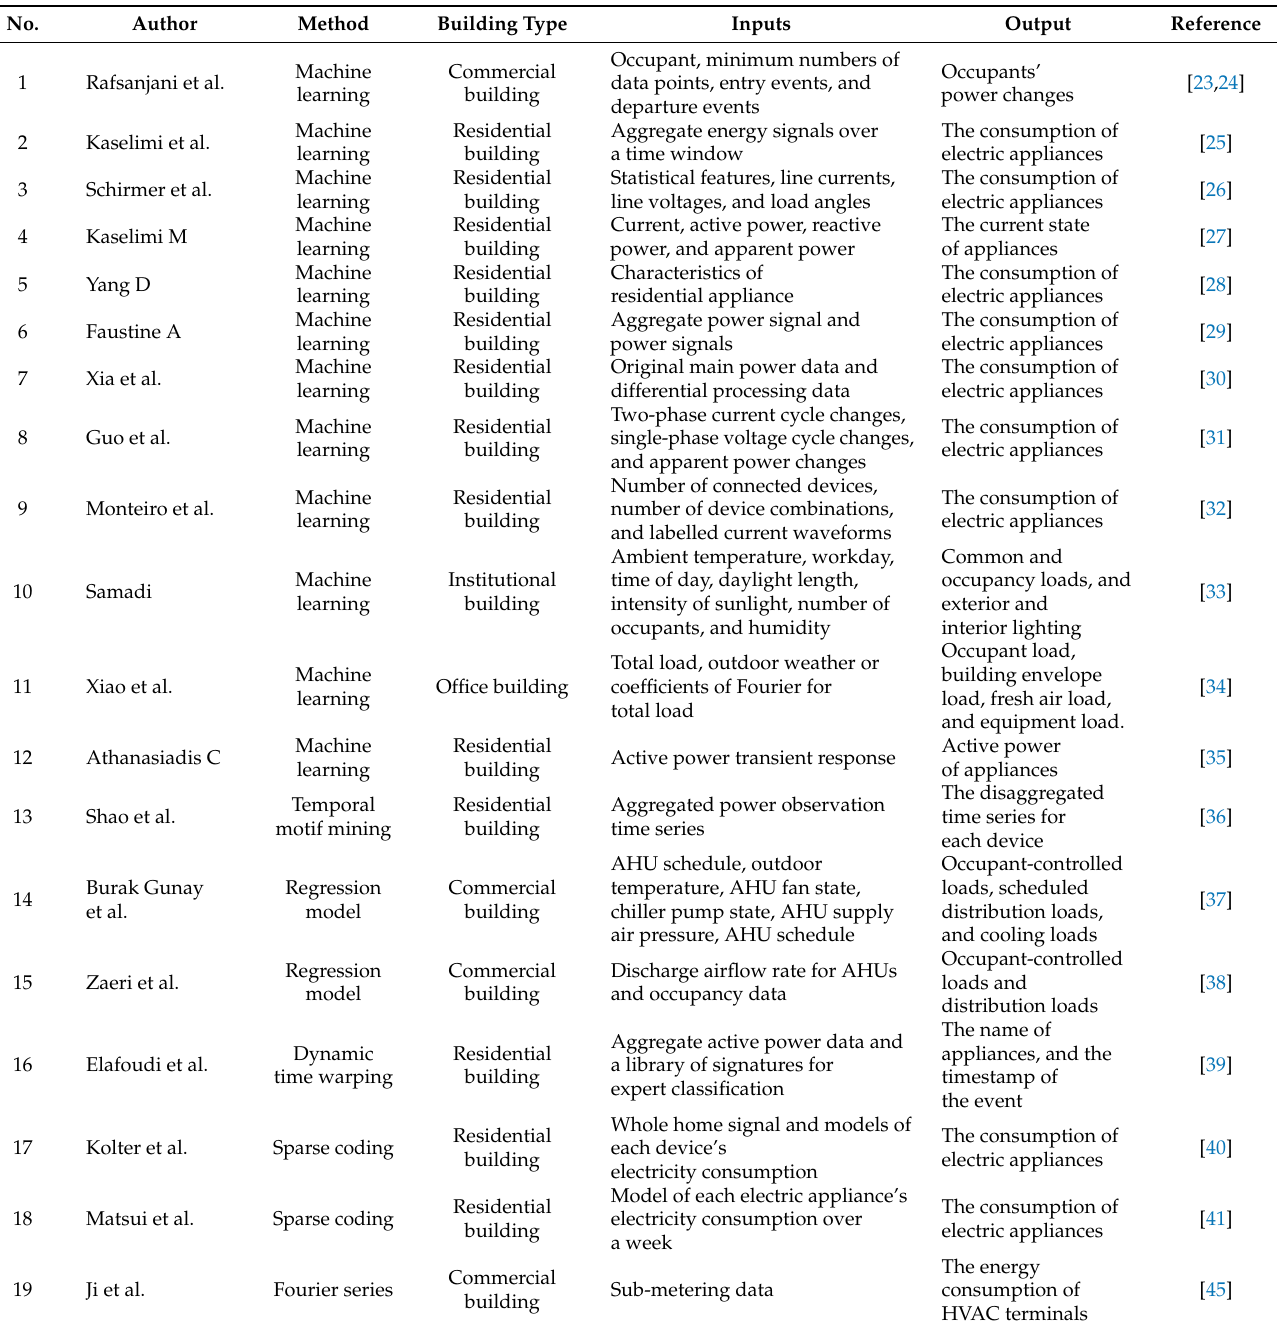
Table 1. Summary of existing NILM